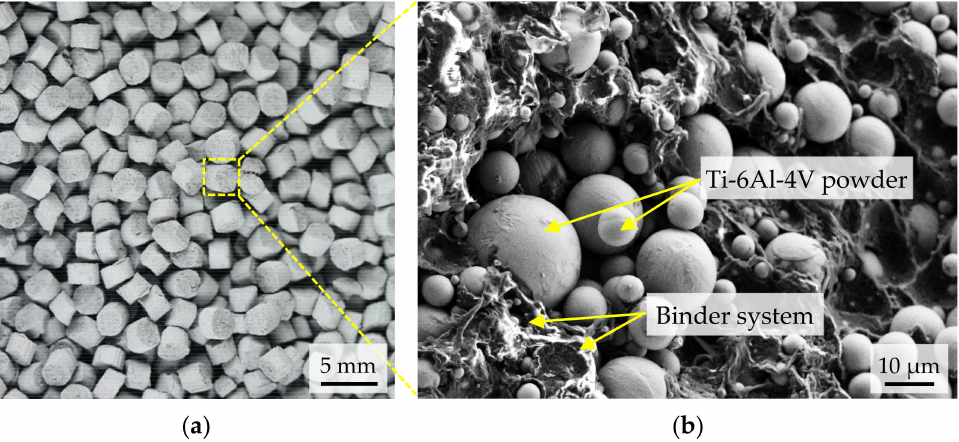
Figure 1. ( a ) Macro shot of granular Ti-6Al-4V feedstock; ( b ) SEM image of feedstock ingredients.